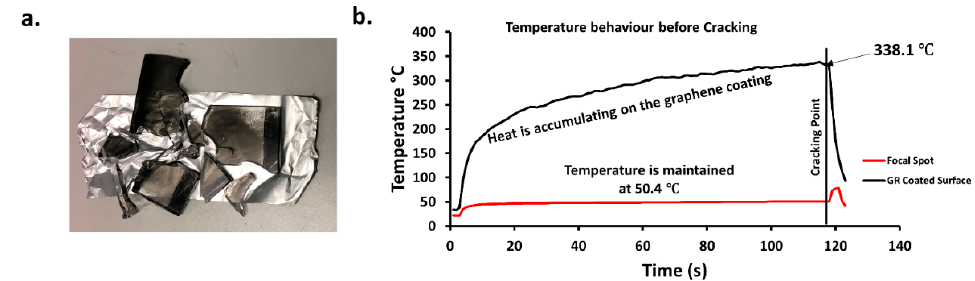
Figure 8. Medium GC sample facing the source of the solar irradiance showing ( a ) the breakage photograph and ( b ) the maximum temperature at the cracking point and the temperature be- haviour.